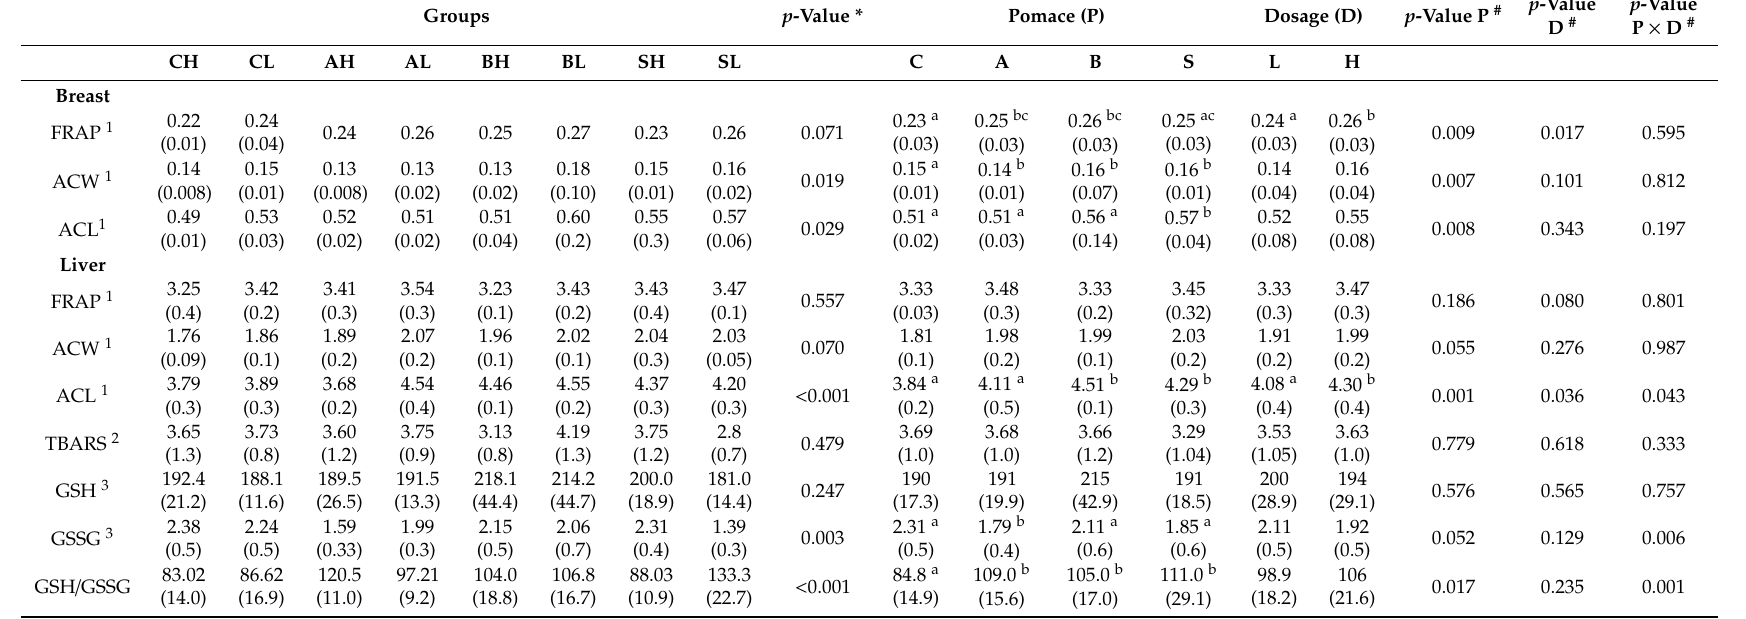
Table 5. Breast and liver antioxidant